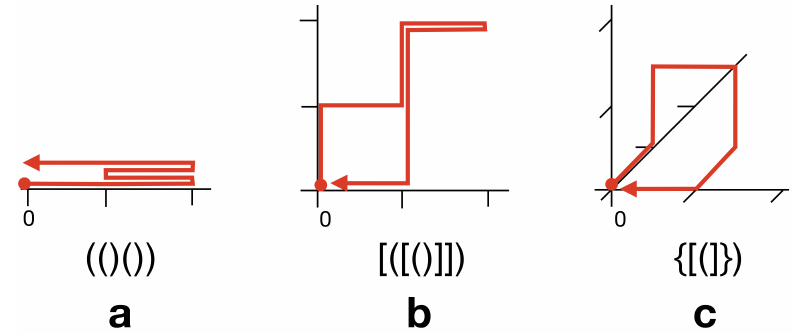
Figure 6. SDL n words as lattice walks: ( a ) A word in the Dyck language, SDL 1 , describes an origin-to-origin walk on the positive half of the integer numberline (1D lattice); ( b ) a word in SDL 2 describes an origin-to-origin walk in the first quadrant of the 2D lattice; and ( c ) a word in SDL 3 describes an origin-to-origin walk in the first octant of the 3D lattice.